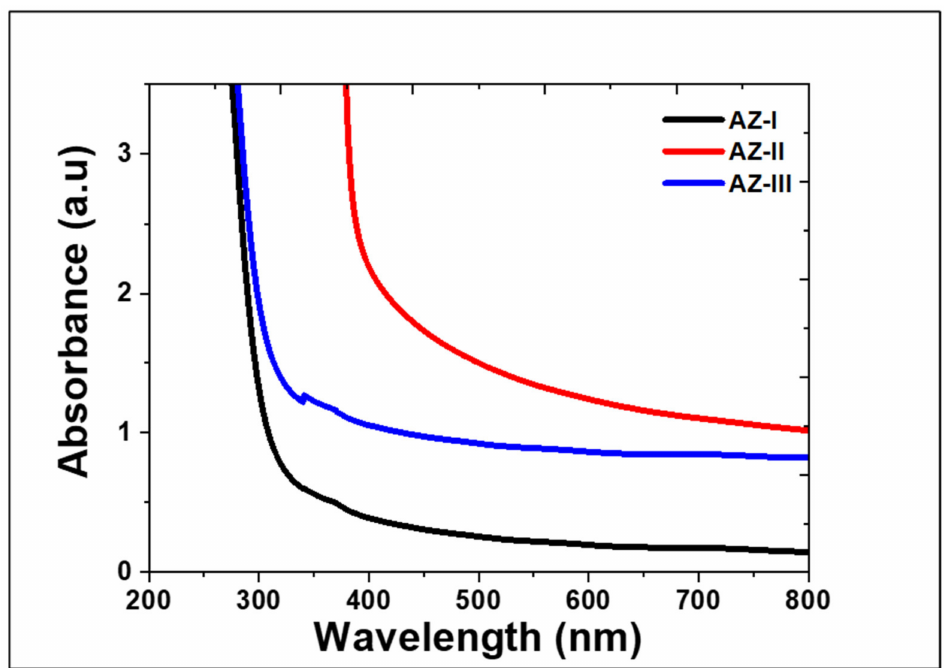
Figure 8. Absorbance spectra of the aerosol deposited ZnO films obtained using different cycles. The shift in absorbance edge of UV for the ZnO films may be caused by the defects generated within the ZnO crystals during the high impact collision during the RTIC. The presence of defects in ZnO films, which act as recombination centres, can be identified using room temperature photoluminescence (RTPL). Figure 9a shows the RTPL spectra of the aerosol-deposited ZnO films, which exhibited a typical near band edge emission (NBE) at approximately ~380 nm and a broad visible light emission (deep level emission, DLE). The NBE is associated with the release of energy due to transition of electrons from the conduction band (CB) to valence band (VB) of ZnO [41]. The maximum peak of NBE for the ZnO films produced at one, two and three deposition cycles are 387, 384 and 383 nm, respectively. In addition, the intensity of NBE was not dominant for all the ZnO films, suggesting a rather low crystallinity of ZnO films.